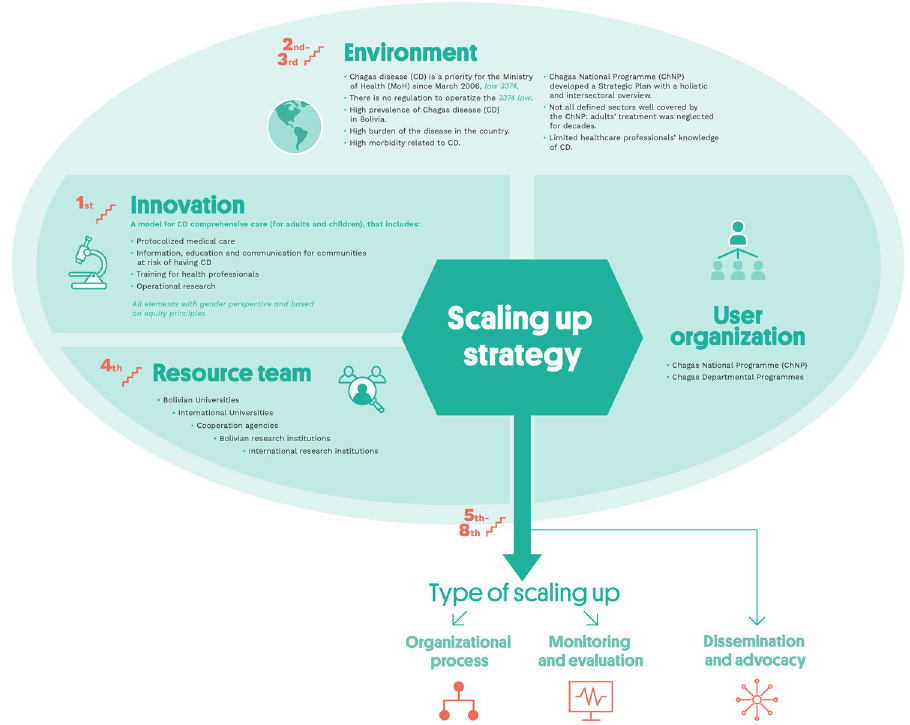
Fig 1. Elements of Chagas Platform at scaling up strategy. Credits:ISGlobal.